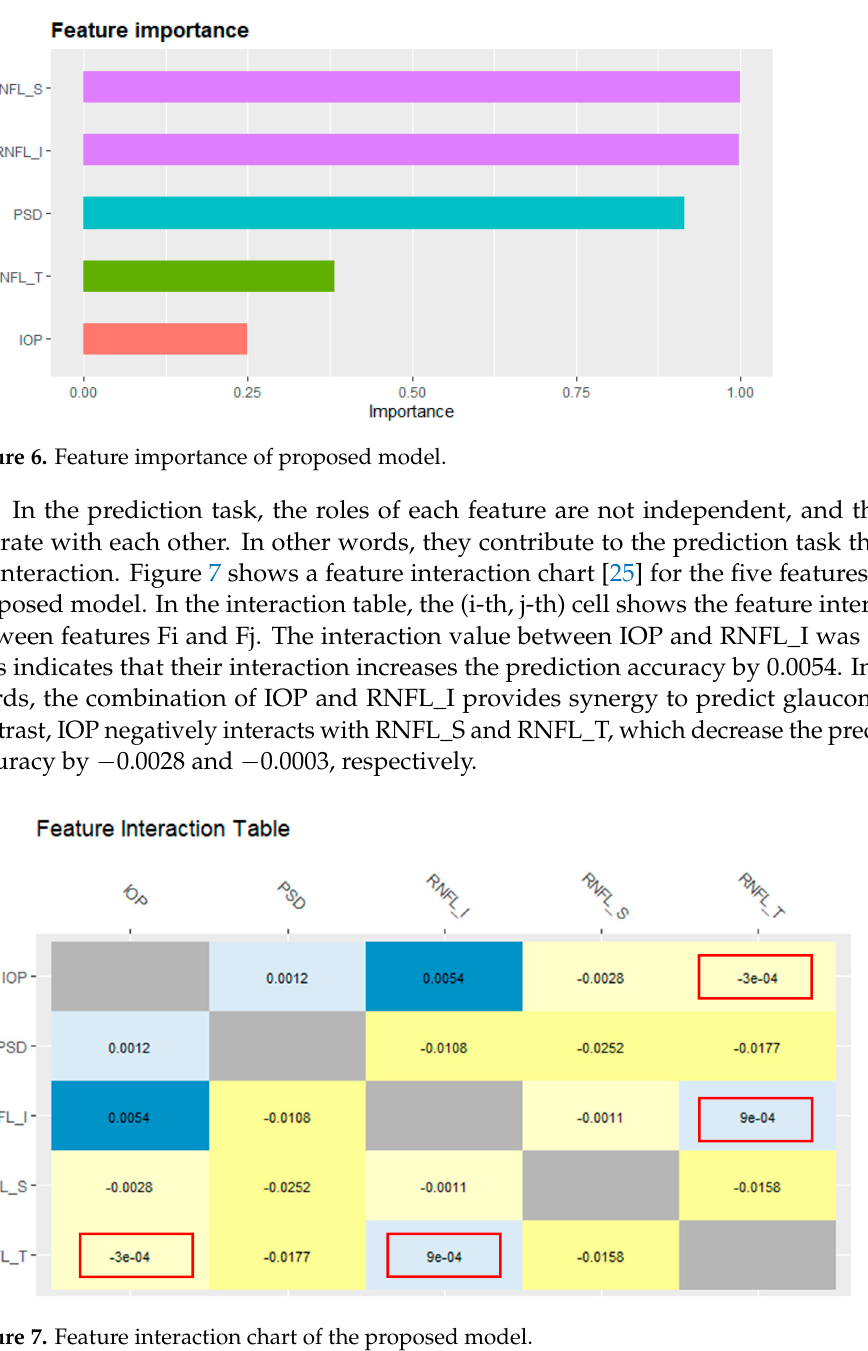
Figure 7. Feature interaction chart of the proposed model.